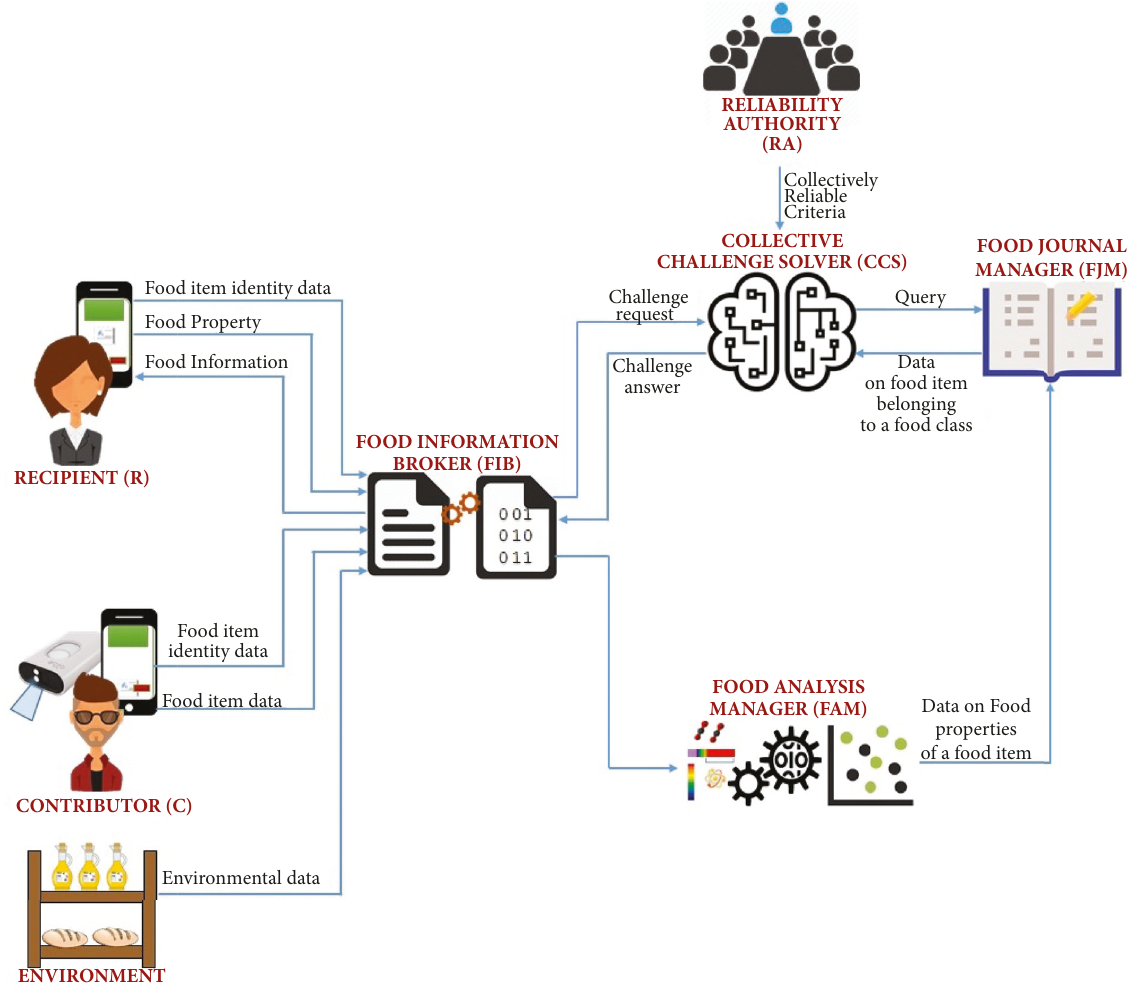
Figure 1: A representation of the Collective process for generating reliable food